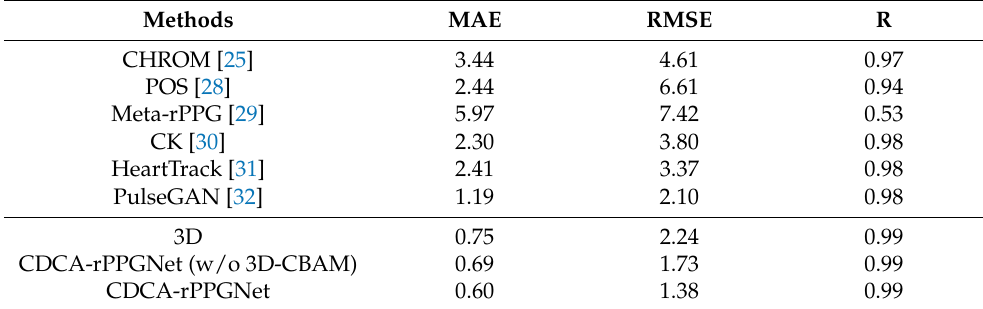
Table 3. HR Estimation Results on the UBFC dataset.